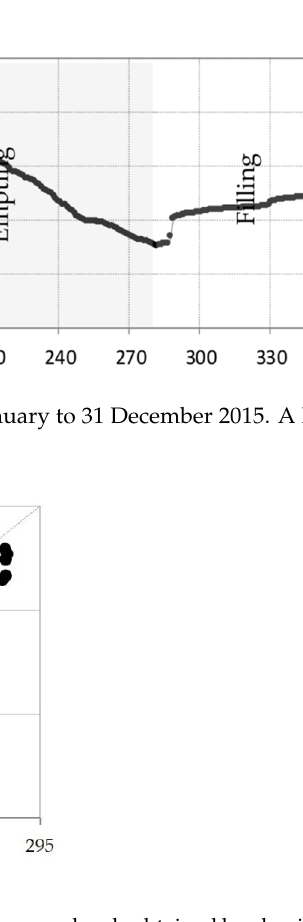
Figure 5. The temporal behaviour of the water surface temperature, T W (K), retrieved by Landsat 8 data, using both 189-034 and 190-034 scenes. A sinusoidal interpolation curve (continuous dashed line) and a confidence band of ±2 × σ XY between measured and interpolated values (dark grey lines) are reported to facilitate the interpretation of the phenomenon. 3.2.2. Air Temperature Air temperature, T A (black dots in Figure 6), follows a similar sinusoidal behaviour. These values were interpolated to facilitate the interpretation of the phenomenon as well. The standard deviation, σ XY , of the difference between measured and interpolated values was ≈ 2.12 K. The amplitude and the average temperature were 9.48 and 291.99 K,